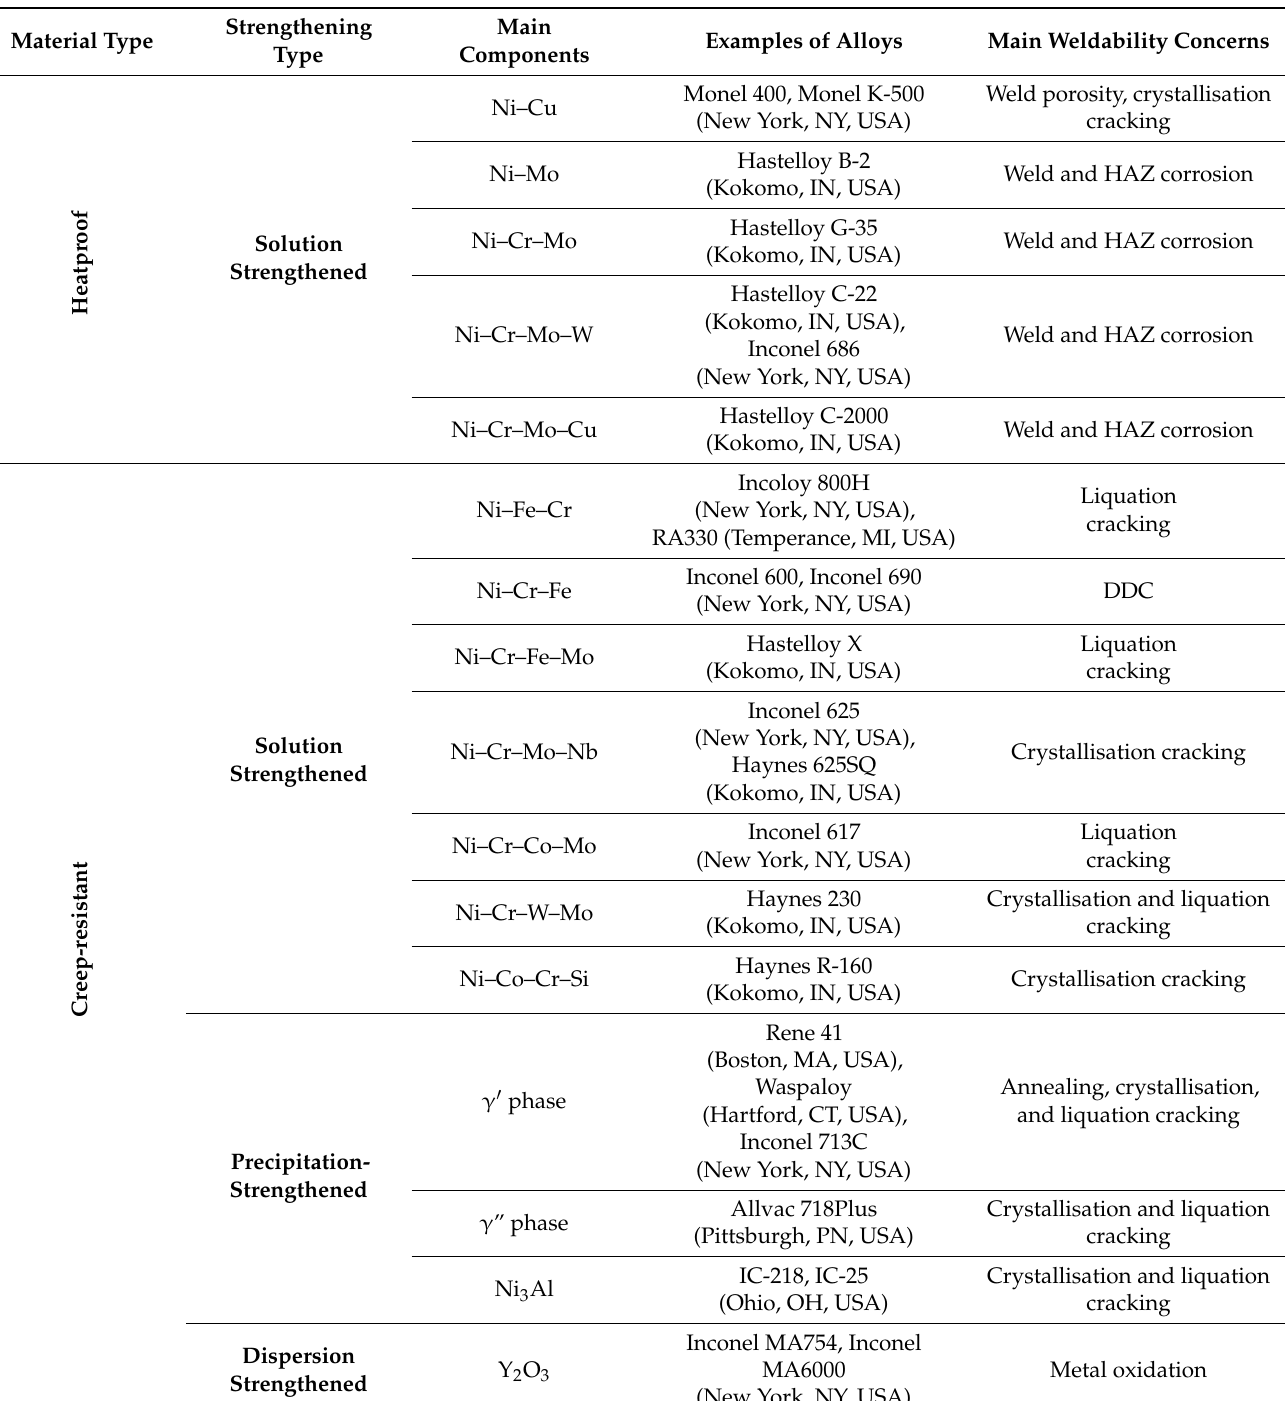
Table 1. The parameters of main weldability concerns for nickel-based alloys